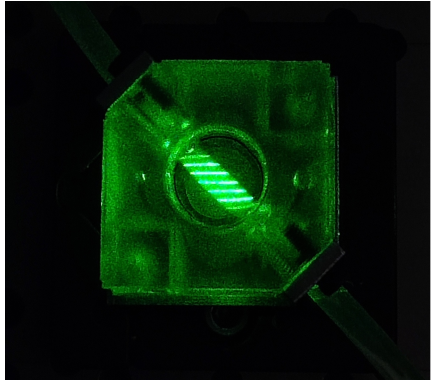
Figure 3. Cube of 6 mm x 6 mm x 6 mm showing the five light- sheets in 3D and cross section.